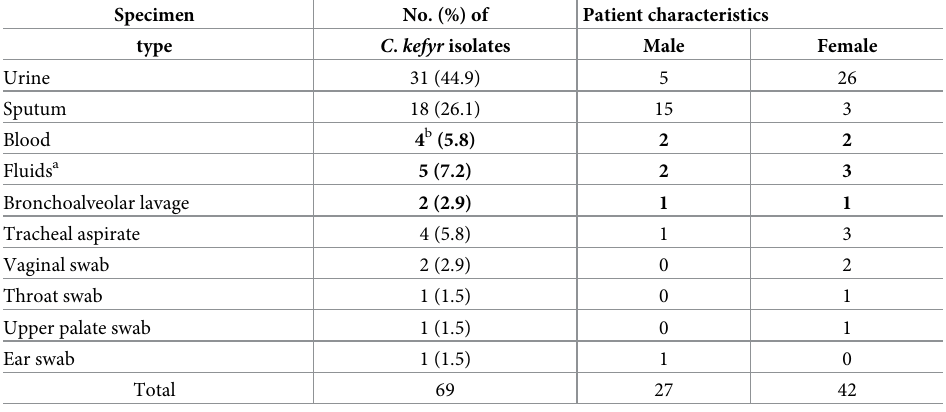
Table 2. Distribution of C . kefyr in different clinical specimens obtained from male and female patients in Kuwait. Specimen No. (%) of